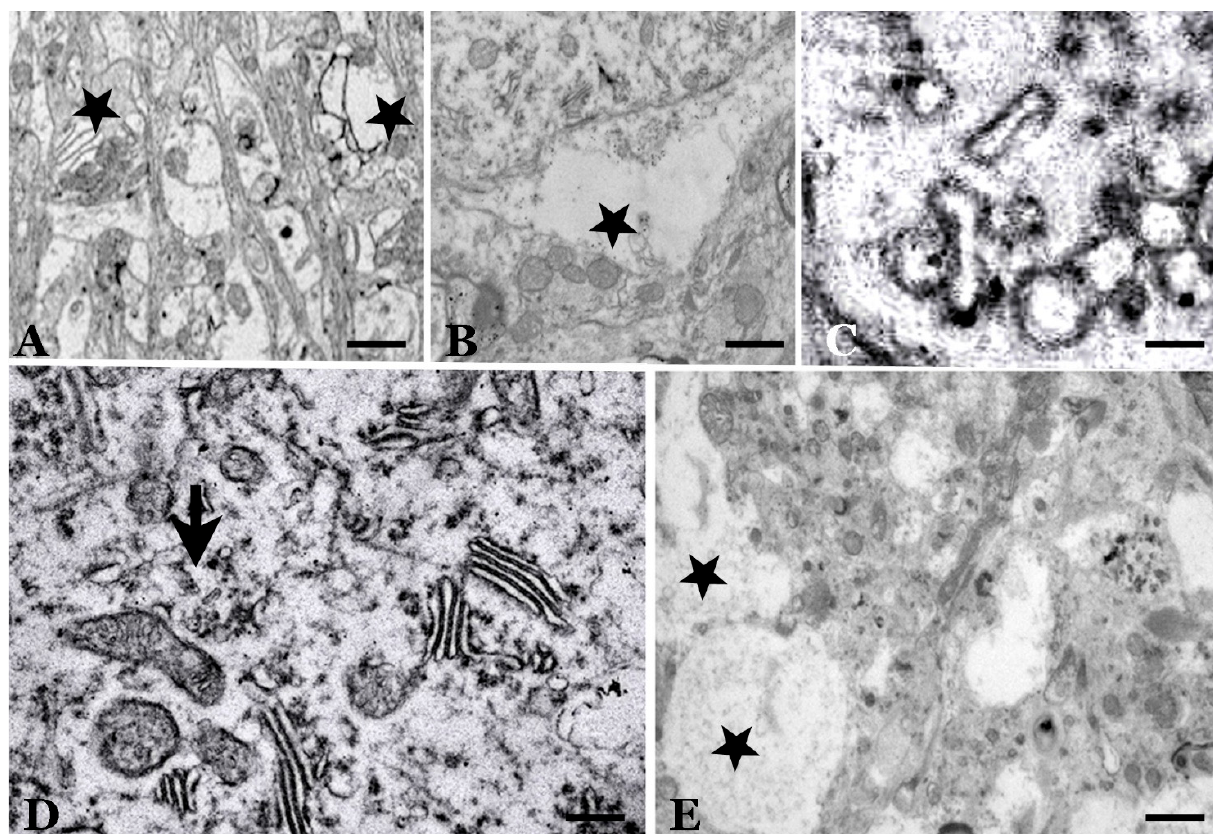
Figure 8. Electron microscopy images of vacuoles and subcellular bodies. ( A ) Dystrophic dendrites of stellate cells of the molecular layer (*), located between parallel fibers, showing autophagic vacuoles. ( B ) Intracellular vacuole without a defined membrane at an axon terminal of a basket cell on a Purkinje neuron (*). ( C ) “Tubulovesicular” formations with translucent content in association with electron-dense vesicles. ( D ) Cytoplasm of dystrophic Purkinje cells with loss of organoids, hypertrophic hypolemmal cisterns and microvesicles (arrow). ( E ) Purkinje atrophic cells surrounded by extraneuronal vesicles (*). They have a dense cytoplasm (“dark neurons”) with a large number of dense vesicular structures that are more or less complex. (Bar: A = 3.5 μ m; B = 0.5 μ m; C = 30 nm; D = 0.5 μ m; E = 1 μ m).